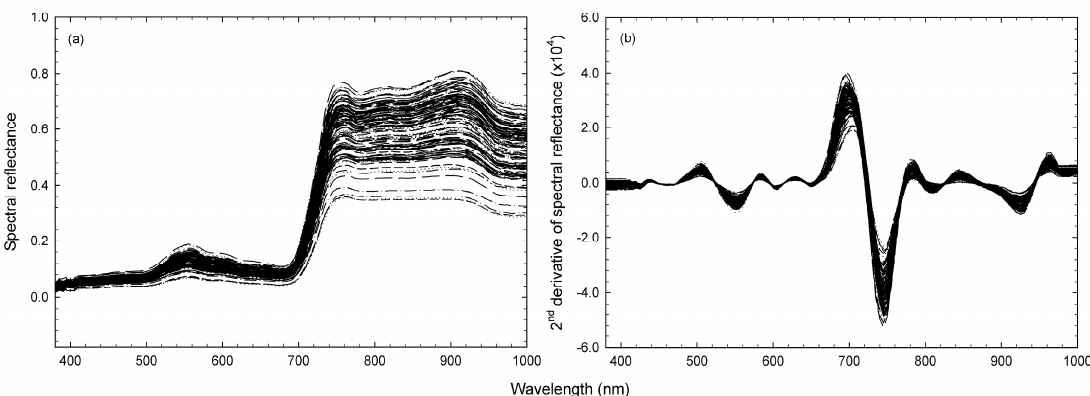
Figure 3. ( a ) Raw and ( b ) second derivatives of spectral reflectance in the range of 380 and 1000 nm from 11 broccoli heads (110 regions of interest).